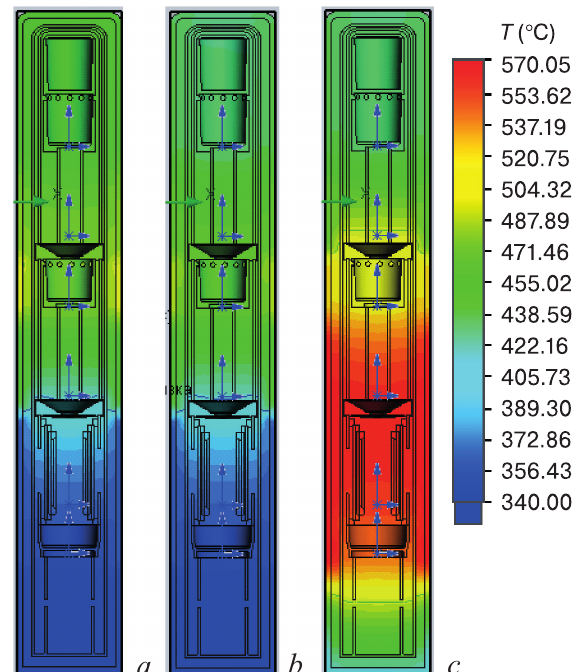
Figure 3. Simulated thermal field distribution along reactor with fittings: ( a ) vacuum degassing, ( b ) second distillation and ( c ) second drain